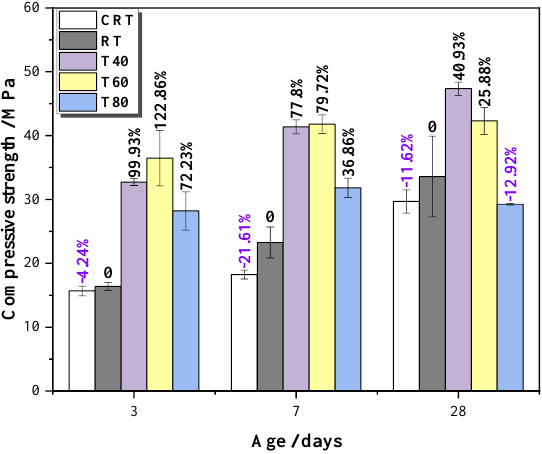
Figure 9. Compressive strength of mortars cured for 3, 7, and 28 days. Table 4. The compressive strength of mortars cured for 3, 7, and 28 days (N/mm 2